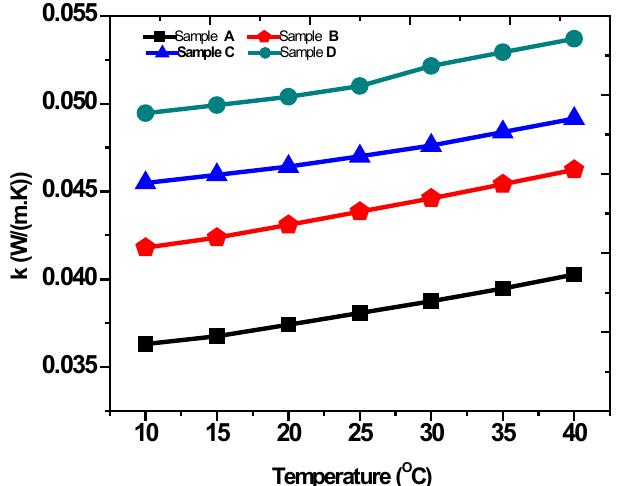
Figure 6. Thermal conductivity of the four prepared samples of insulation composite differing in density.